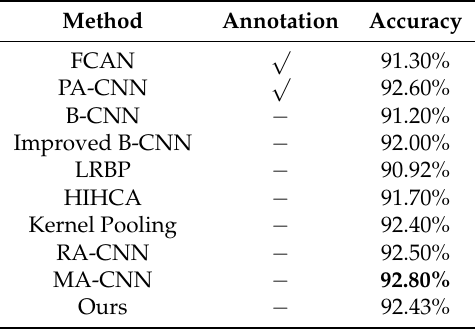
Table 5. Comparison with previous methods on Cars-196.